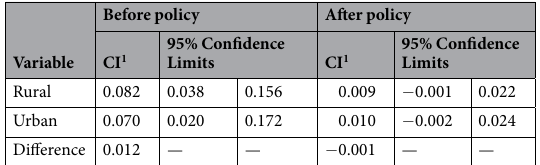
— Table 3. Inequality of urban and rural women’s hospital delivery before and after China’s Rural Hospital Delivery Subsidy policy (n = 2398). 1 CI: Concentration Index.